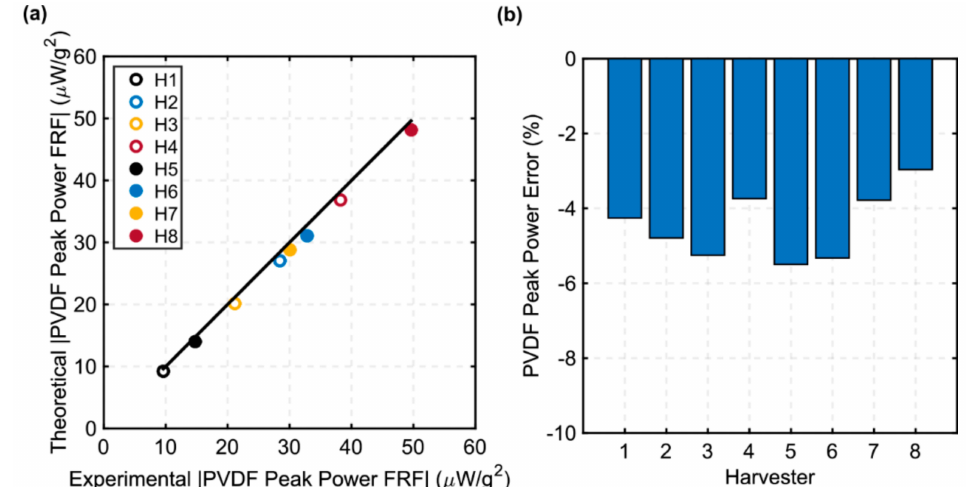
Figure 6. Comparison between experimental and equivalent concentrated tip mass model results. ( a ) Measured vs predicted PVDF peak power of the eight harvesters. ( b ) Prediction error for PVDF peak power as compared to experimental measurements.